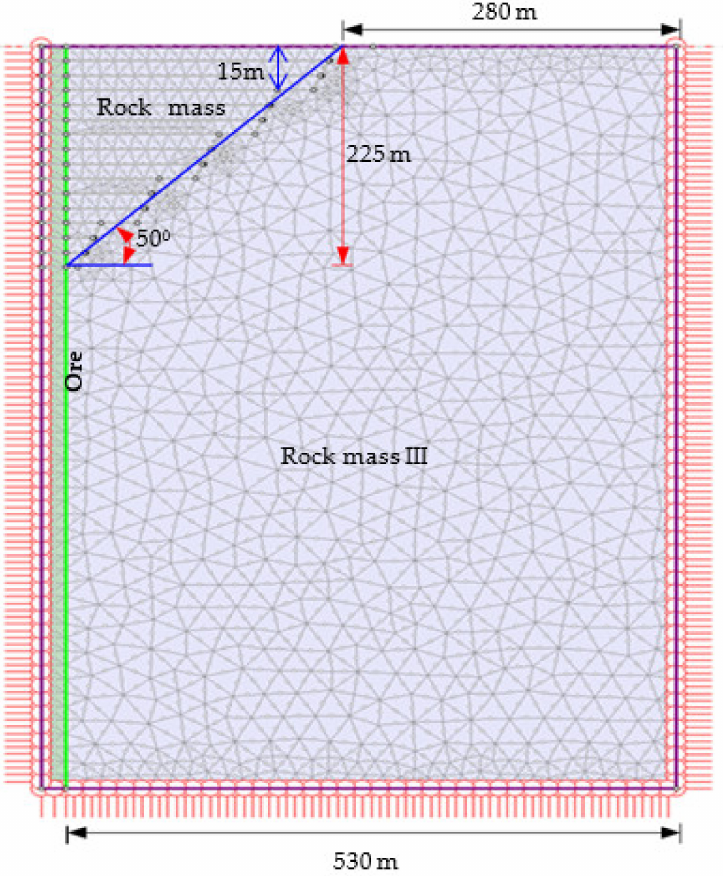
Figure 2. Model setup shows geometry, boundary conditions (BCs) and meshing before excavation (e.g., slope angle =